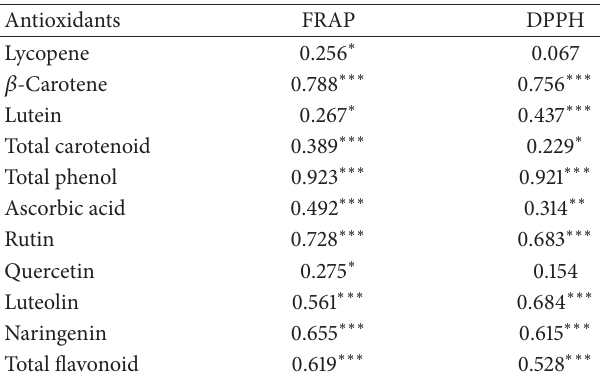
Table 5: Linear correlations between antioxidants and antioxidant activities of tomato